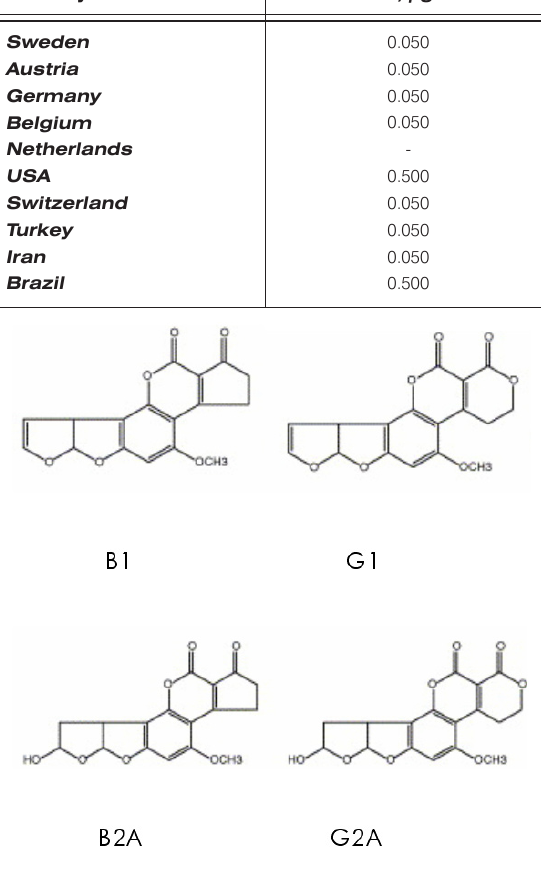
Table 2. Safe limits of AFM1 in dairy foods for some countries [62-67]. Country